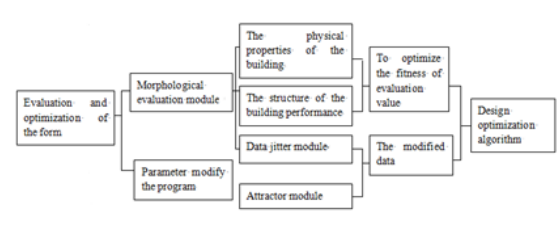
Figure 3: Design evaluation and